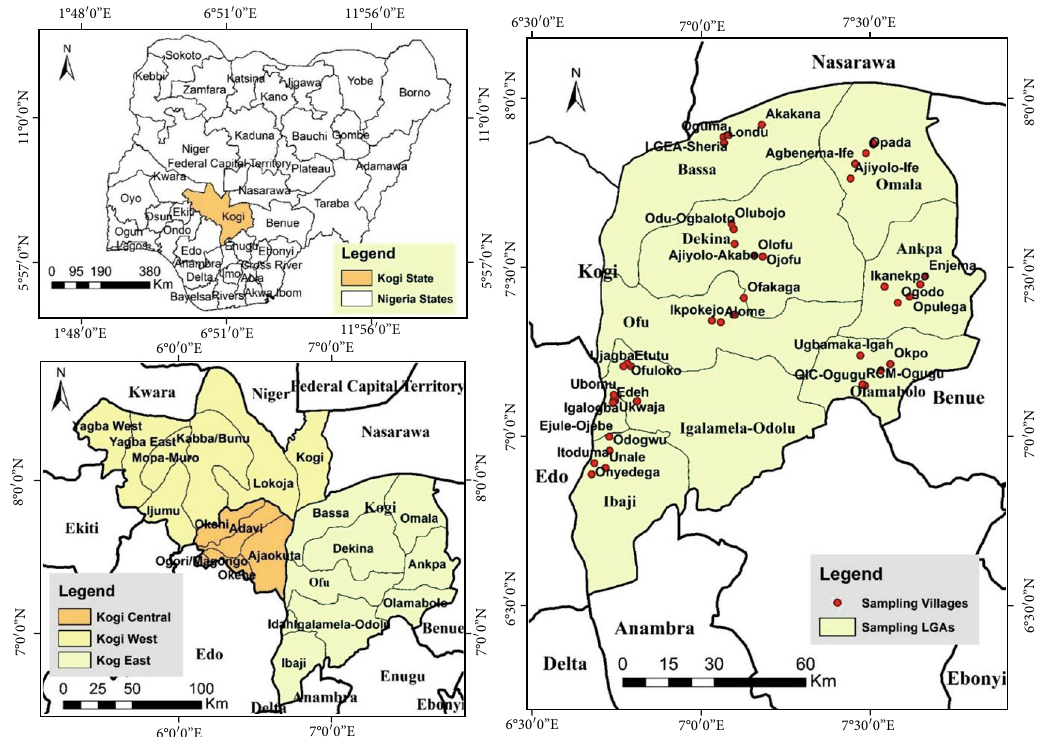
Figure 1: Sampled villages in Kogi East Senatorial District, Nigeria (source: Map Gallery, Geography Department, Ahmadu Bello University,